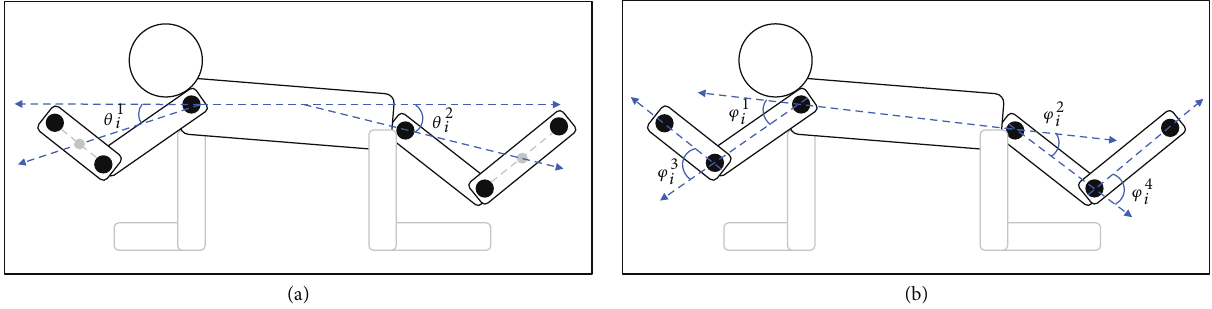
Figure 2: A schematic diagram of the angles at frame i used in the calculation of AGs. θ s are used for AG1 (a), and φ s are used for AG2 and AG3 (b). All angles range from 0 to 180 degrees.